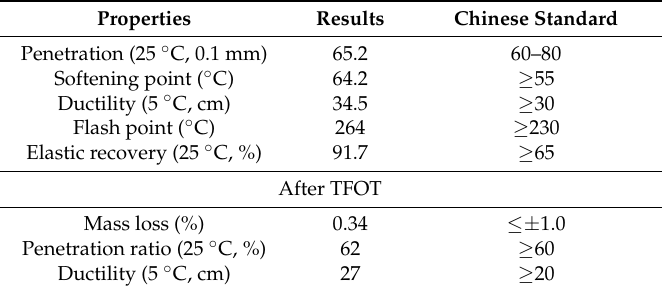
Table 1. Properties of SBS-modified bitumen.